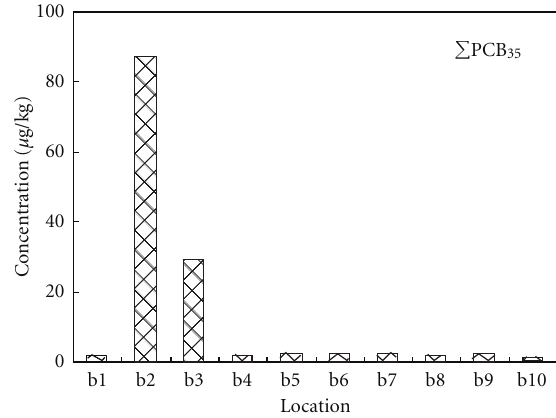
F 2: Relationship between TOC and total PAHs in the studied sediments.